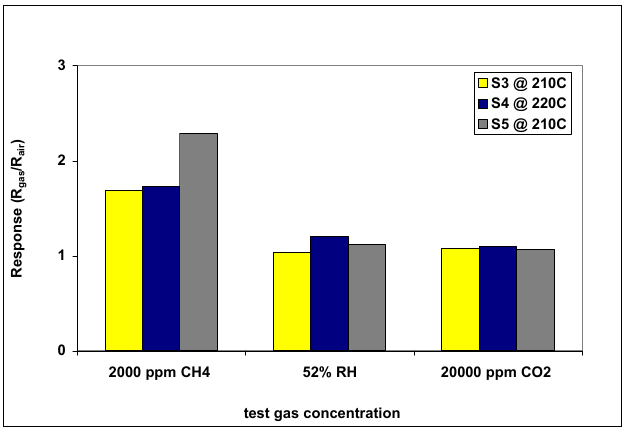
Figure 31. S3, S4, S5 cross-response for different tested target gas concentrations, from ref. [155]. The last tested sensor parameter was its stability over a 6 month period (from the initially performed gas-sensing measurements). To this end, S3 was tested repeatedly under identical conditions during a 6 months interval, to check for modifications of the response/recovery characteristics, regarding CH 4 detection. The obtained results are presented in Figure 32.